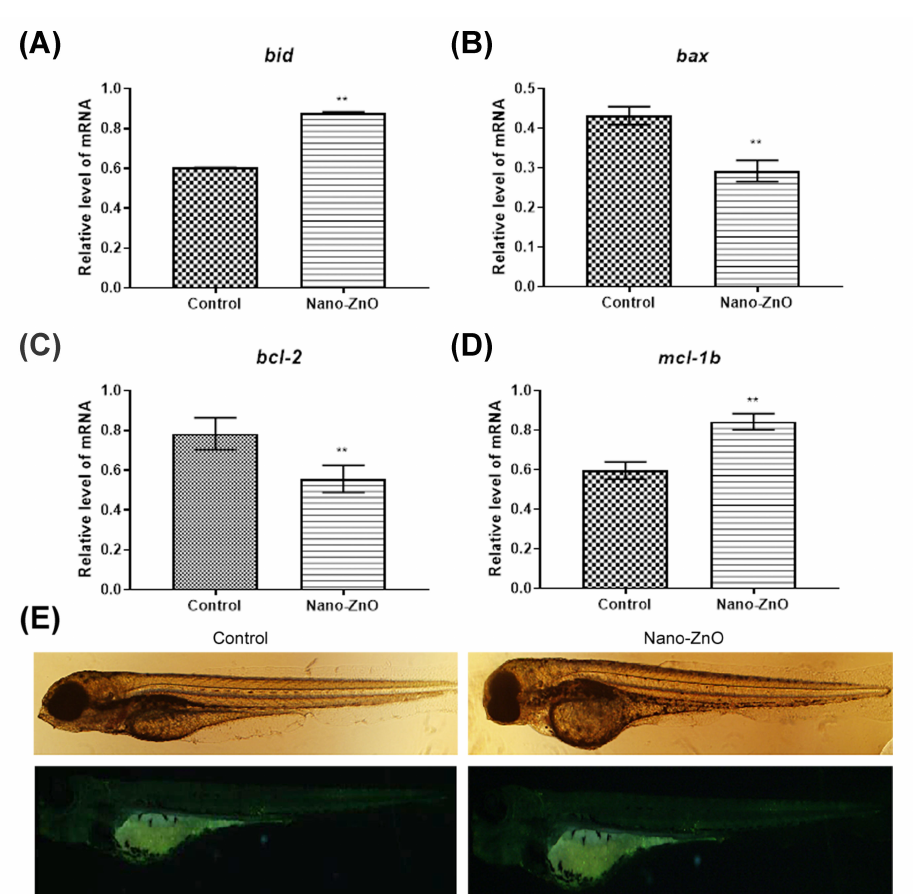
Figure 5. Effect of 125 nmol/mL Nano-ZnO on apoptosis in zebrafish. Changes in mRNA level of pro- apoptosis genes ( A ) bid and ( B ) bax, and anti-apoptosis genes ( C ) bcl-2 and ( D ) mcl-1b. ( E ) Acridine orange apoptosis staining. ( n = 30, ** p < 0.01).